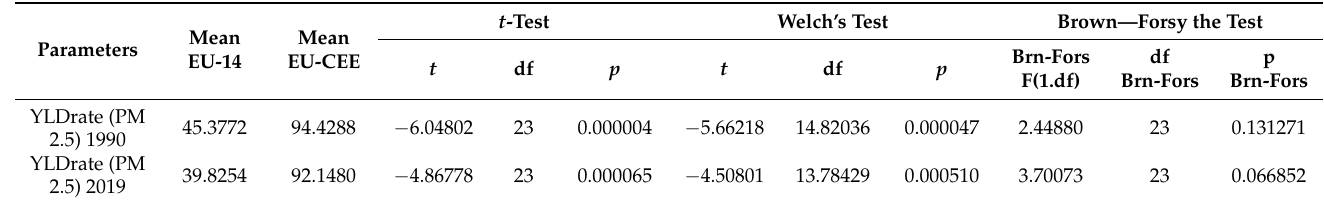
Figure 4. Spatial distribution of YLD rate parameters, population aged 20–54 (EU-27, in 1990 and 2019). ( a ) Ambient particulate matter pollution (PM 2.5). ( b ) Household air pollution from solid fuels (HAP). Table 3. Parameters of a Normal